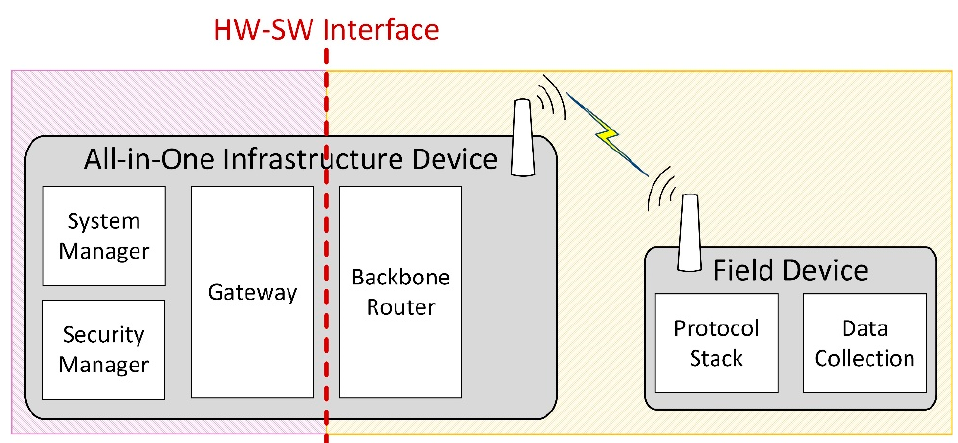
Figure 4. HW-SW interface in the HIL scenarios.